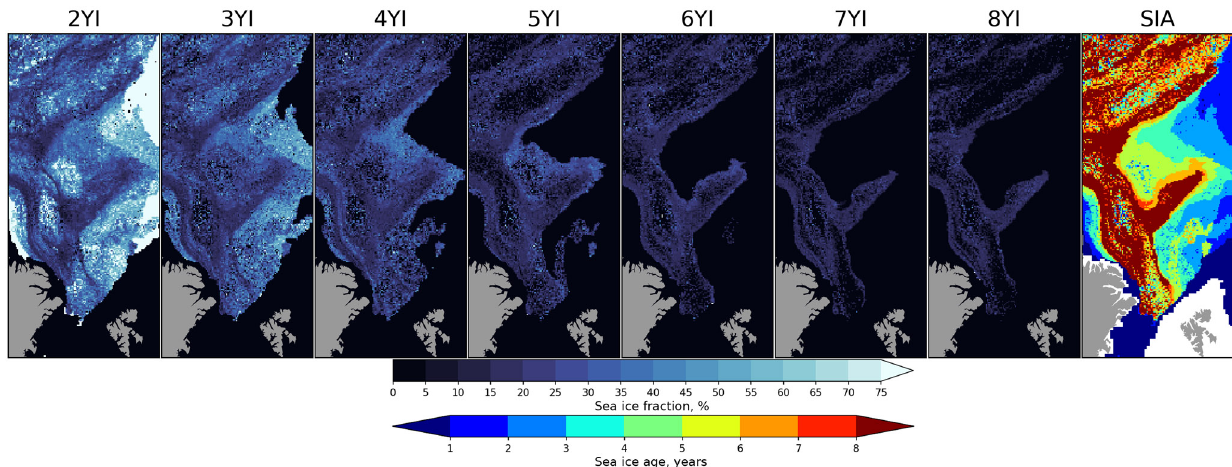
Figure 1. Sea ice age fractions for 1 January 1985 in the Greenland and Lincoln seas. It is clearly seen that in many areas the fraction of 8YI does not exceed 20%, but the corresponding SIA map shows that the entire pixel is assigned to contain